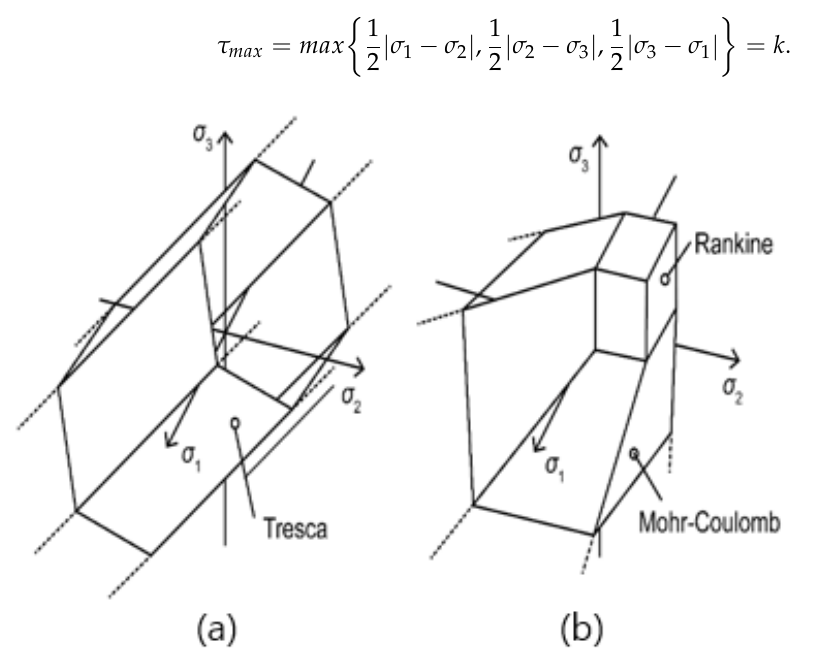
Figure 2. Linear yield criteria in principal stress space [17]. ( a )Tresca model; ( b )M–C